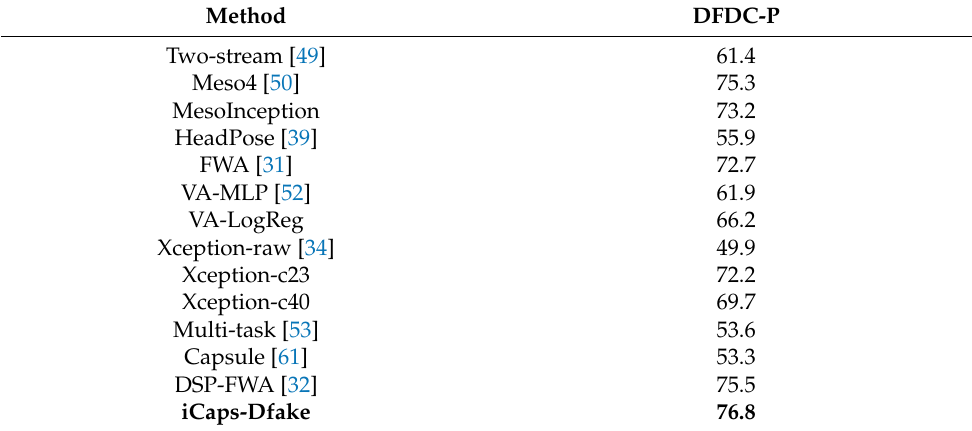
Table 3. Frame-level Area-Under Curve (AUC) scores (%) for the proposed iCaps-Dfake model compared to previous detection methods when tested by DFDC-P.